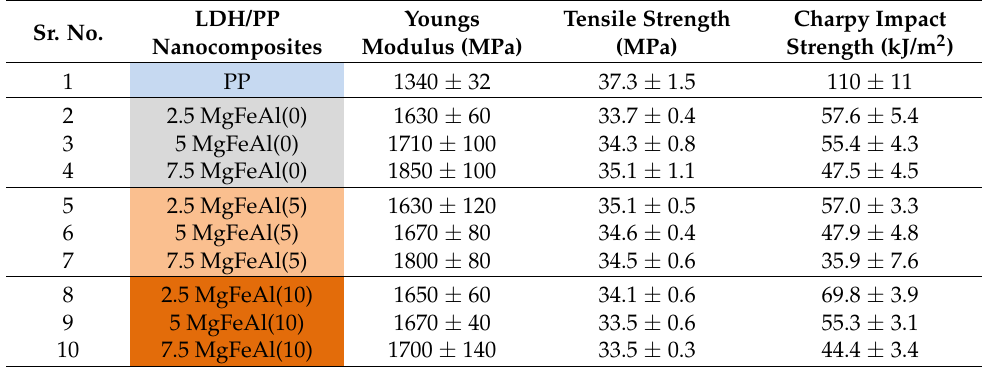
Table 5. Mechanical properties of different LDH/PP nanocomposites.